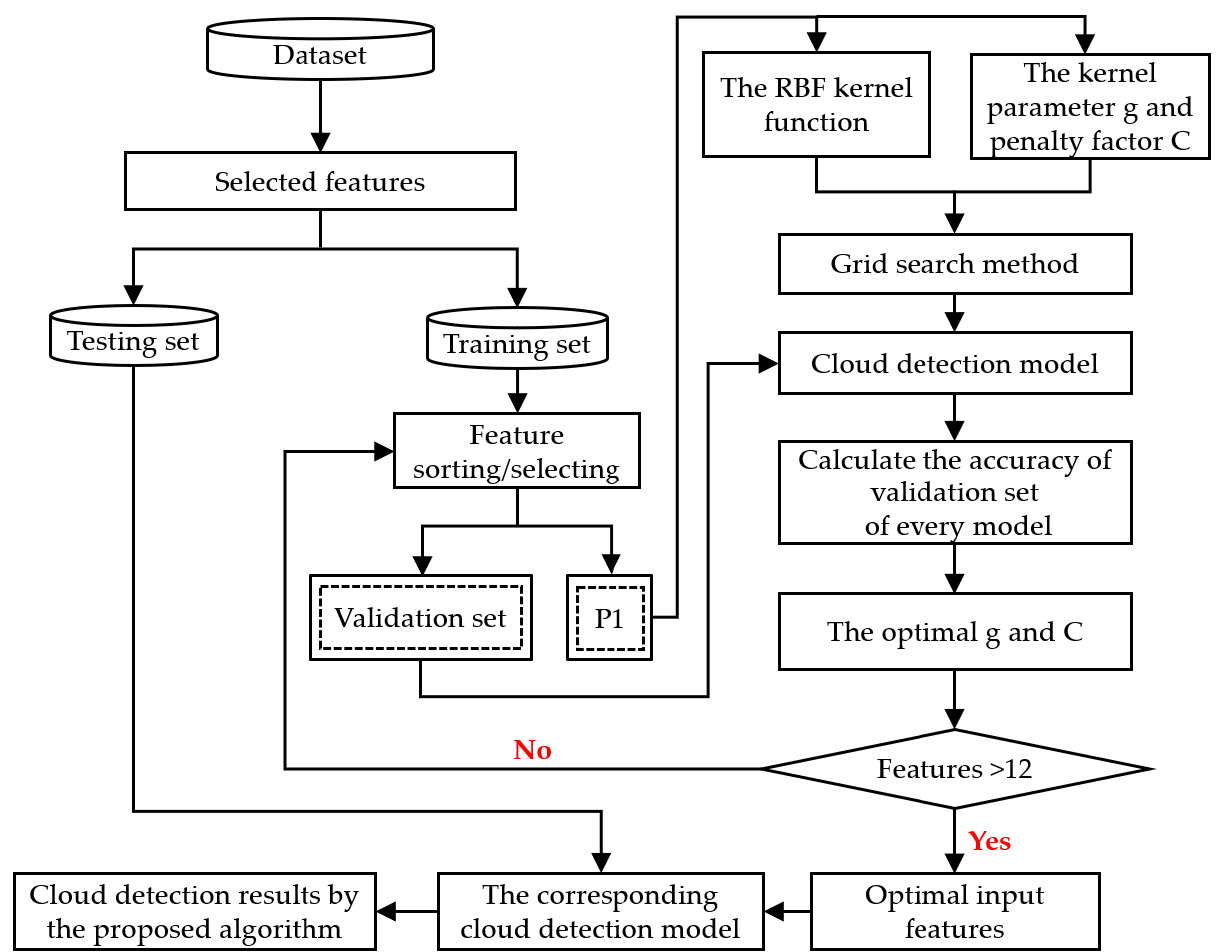
Figure 4. Research process of the cloud detection algorithm based on AERI measurement data. Table 5. The detection results of the validation set of the cloud detection model corresponding to the number of features from 1 to 12.